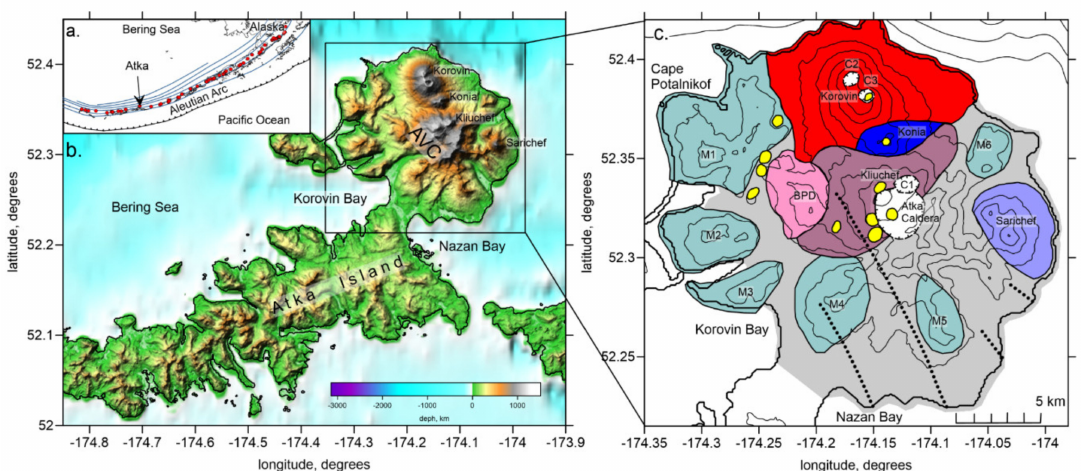
Figure 1. General framework of the study area. ( a ) Aleutian arc and Holocene volcanoes (red dots). The location of the subducting slab is indicated by grey contour lines at every 50 km depth. ( b ) Topography of the Atka Island. AVC is Atka Volcanic Complex. ( c ) Major structural elements within the AVC. White areas depict volcanic craters and caldera. Yellow areas indicate geothermal fields. Light grey background indicates the location of the Pra-Atka shield volcano. Light blue areas indicated by M1 to M6 highlight areas of extinct vents. BPD is a place of the Big Pink Dacite flow. Dotted lines are the dike